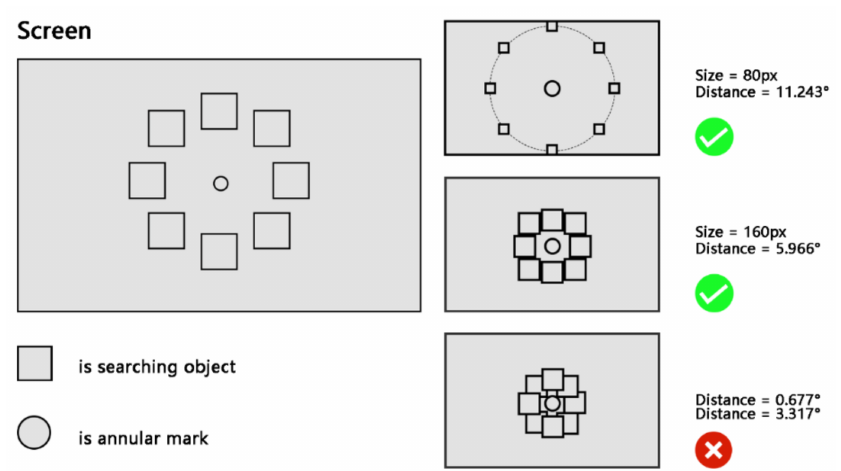
Figure 8. Extreme positions and overlap phenomena: ‘right’ indicates a normal condition that occurs in the experiment, and ‘cross’ indicates a condition that is not allowed to occur in the